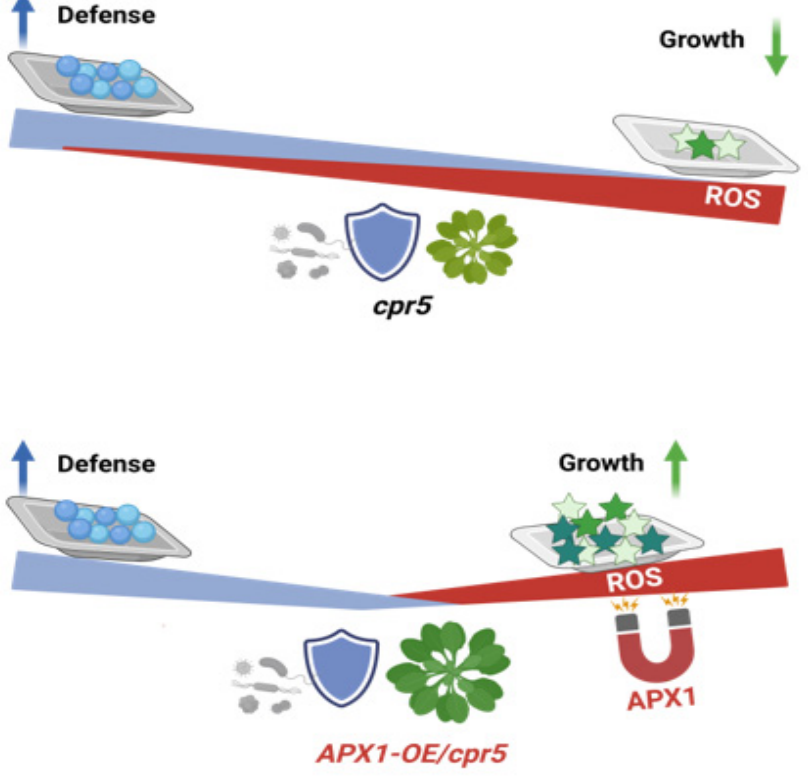
Figure 7. Schematic model. APX1 overexpression in the cpr5 mutant restored growth impairment by scavenging excess cytosolic ROS accumulation while maintaining enhanced disease resistance in Arabidopsis. Figure is created with biorender.com.